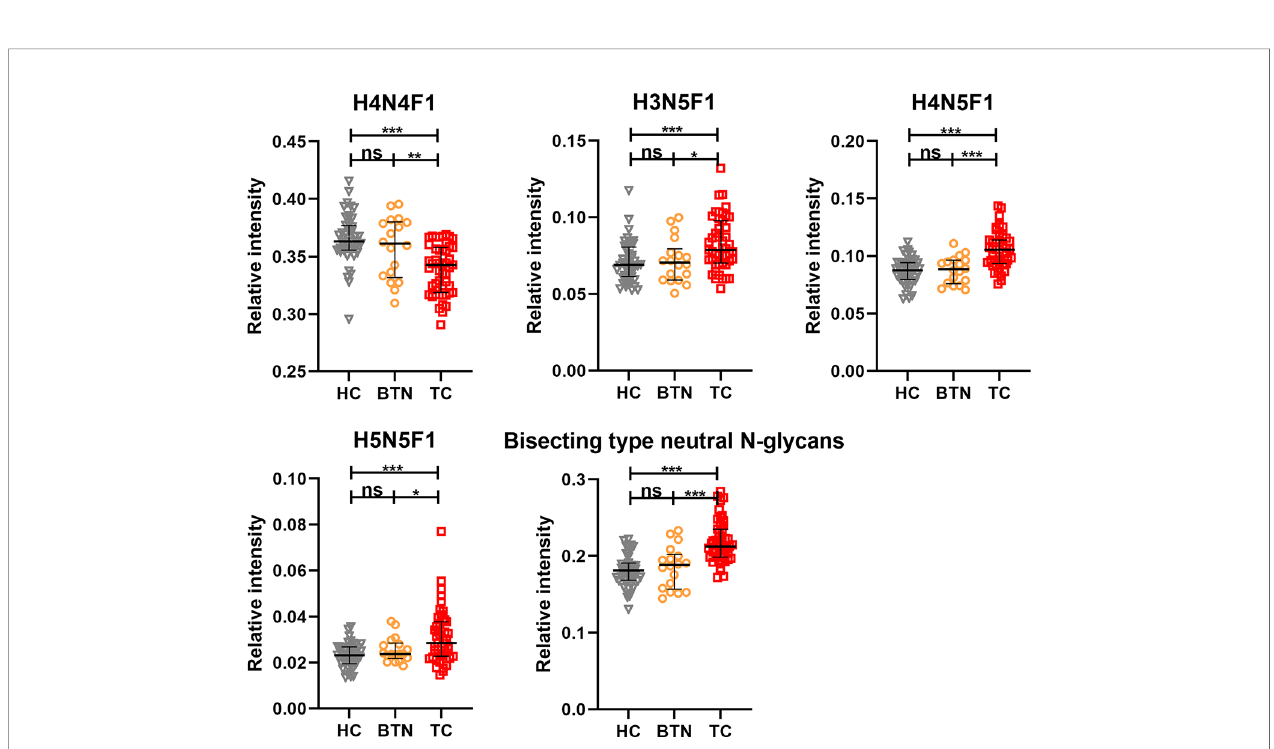
FIGURE 3 | The scatter plots of main replicated directly detected and derived glycan traits in thyroid cancer (TC), benign thyroid nodules (BTN) and healthy controls (HC) for the validation cohort. The whiskers represent “ median with IQR ” . ***p-value < 0.001, **p-value < 0.01, *p-value < 0.05, ns, not signi fi cant (after Bonferroni correction).